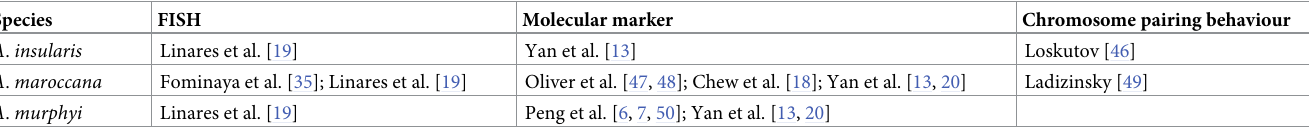
Table 3. Evidence for the DC genome assignment of the tetraploid species in the section Pachycarpa . Species FISH Molecular marker Chromosome pairing